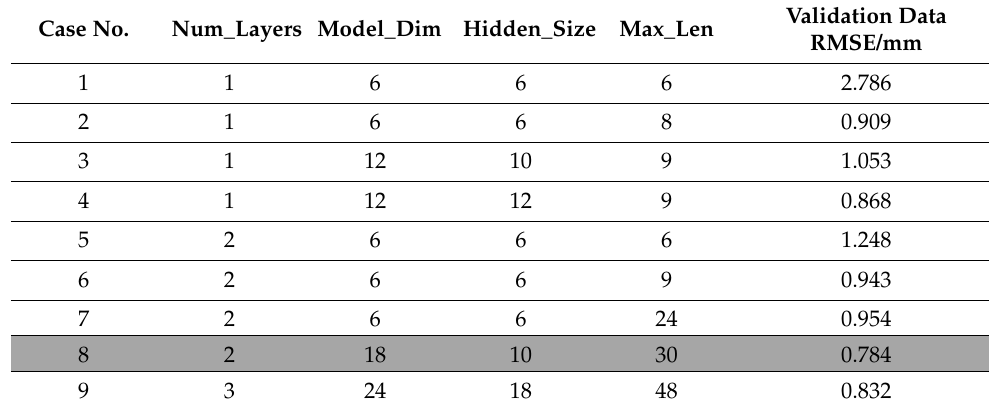
Table 2. Transformer parameter tuning and final model selection based on validation data. Case No.